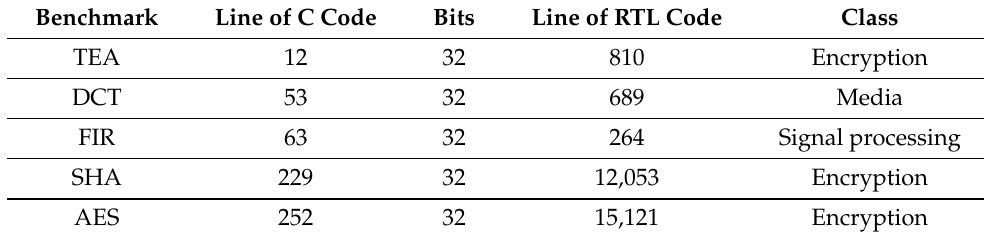
Table 4. Characteristics of the examples used in our